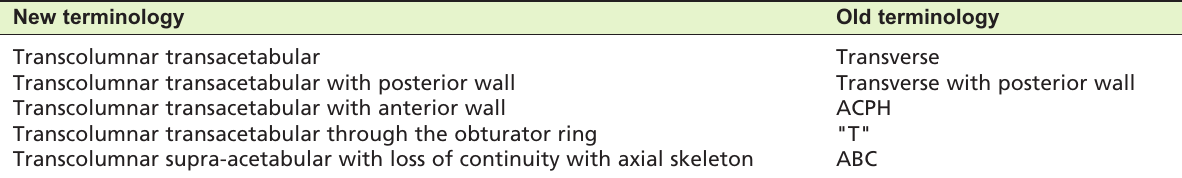
The new terminology in the proposed Table III: